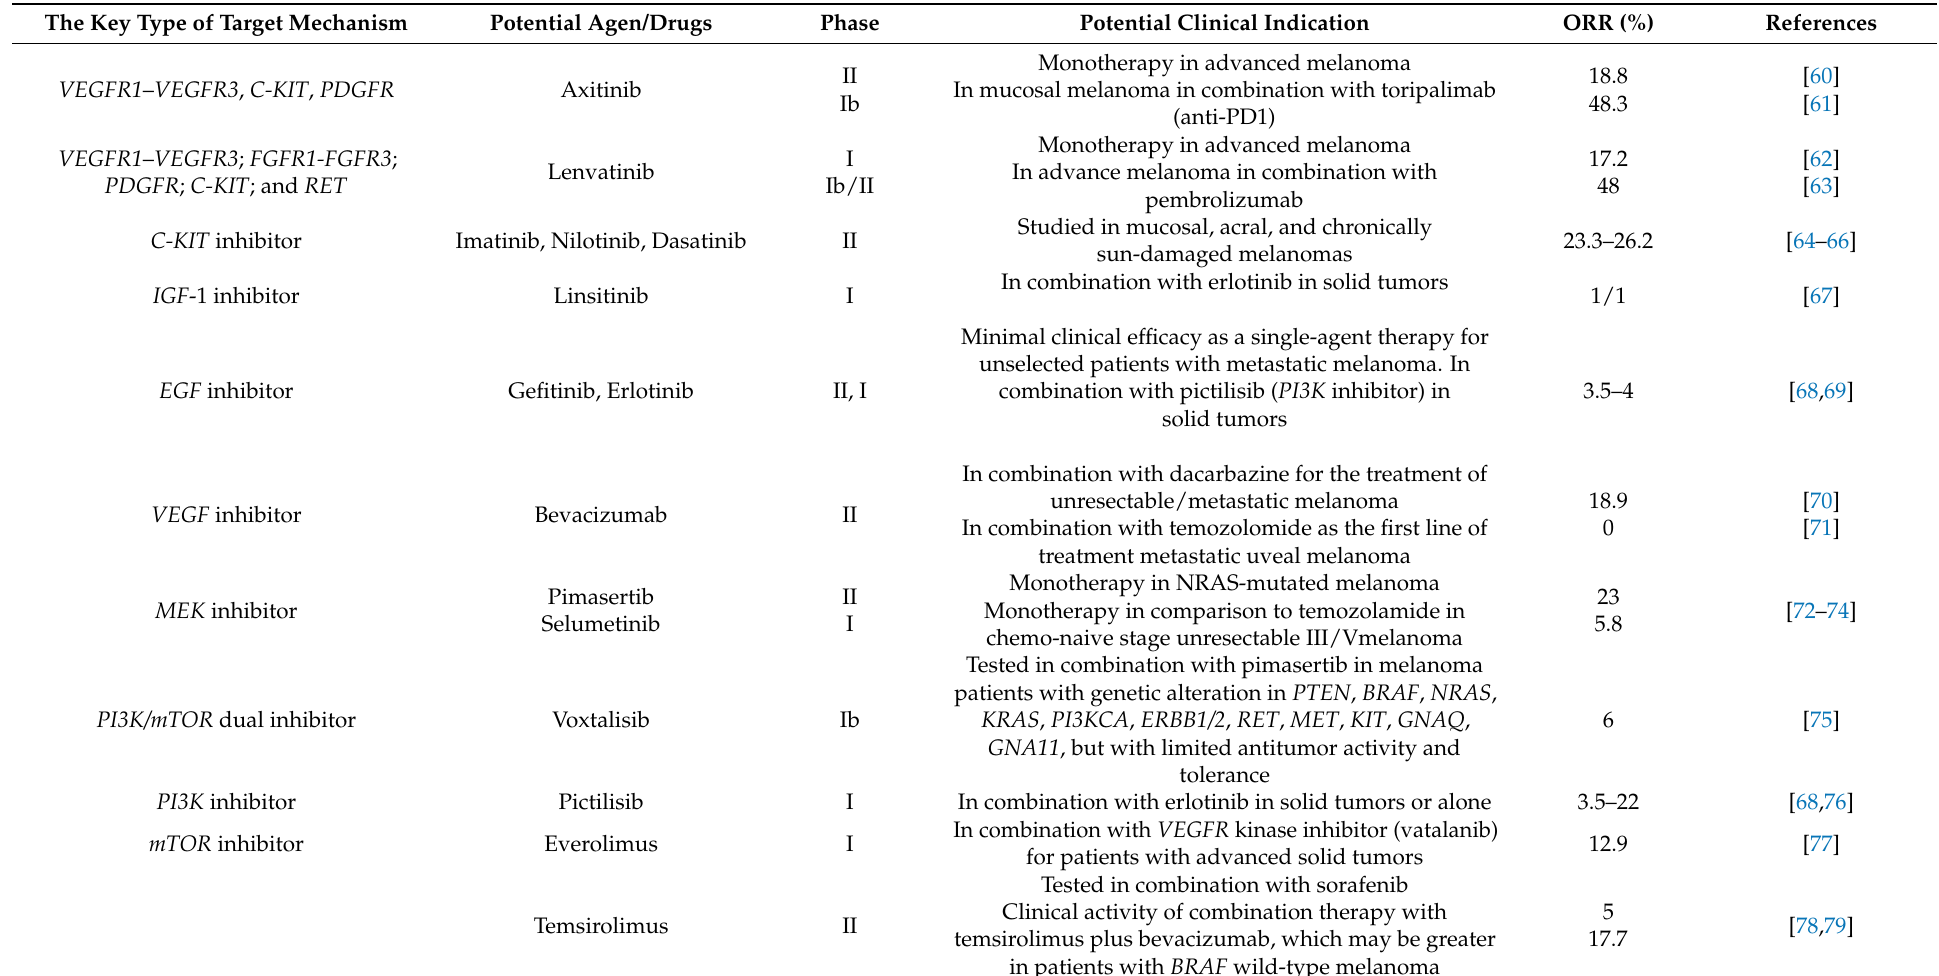
Table 3. Potential targets in